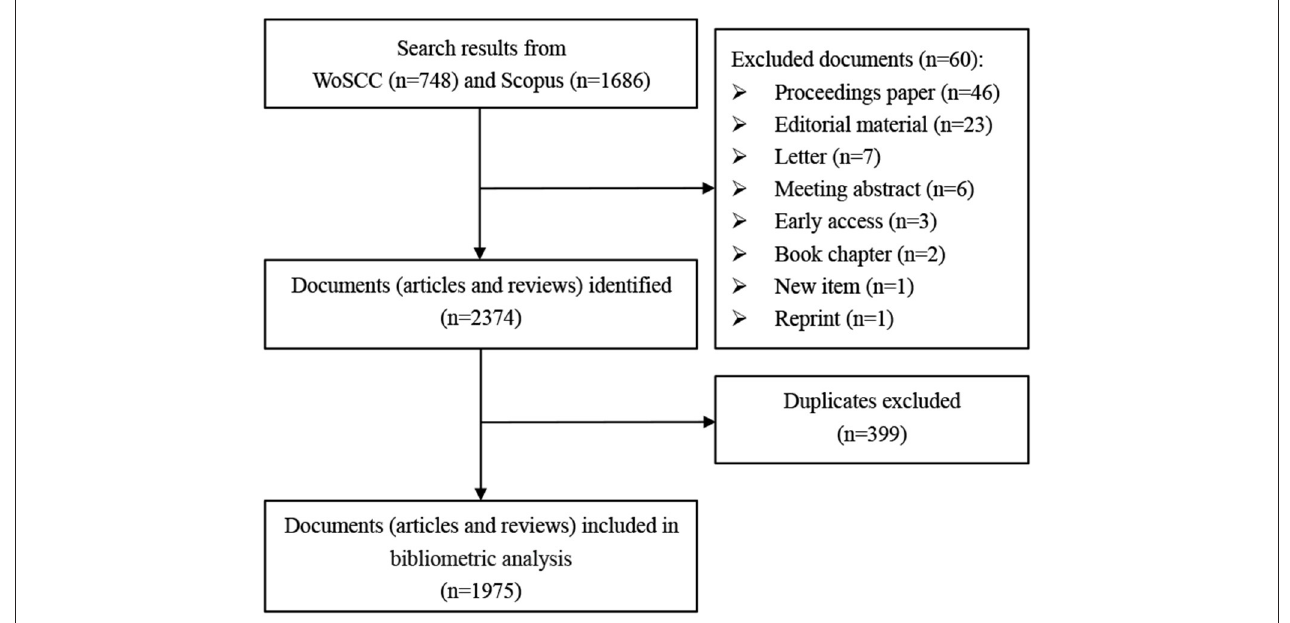
FIGURE 1 | Flow chart detailing the paper collection and screening process. WoSCC, Web of Science Core Collection.